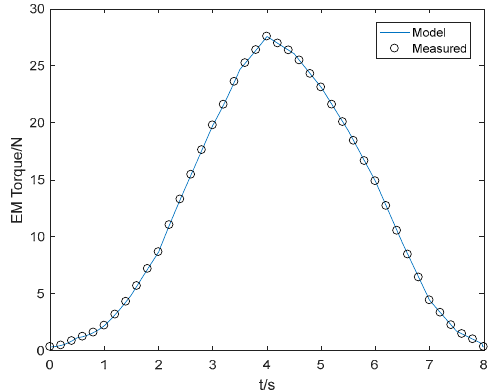
Figure 6. Performance of the Preisach model at h = 1.15